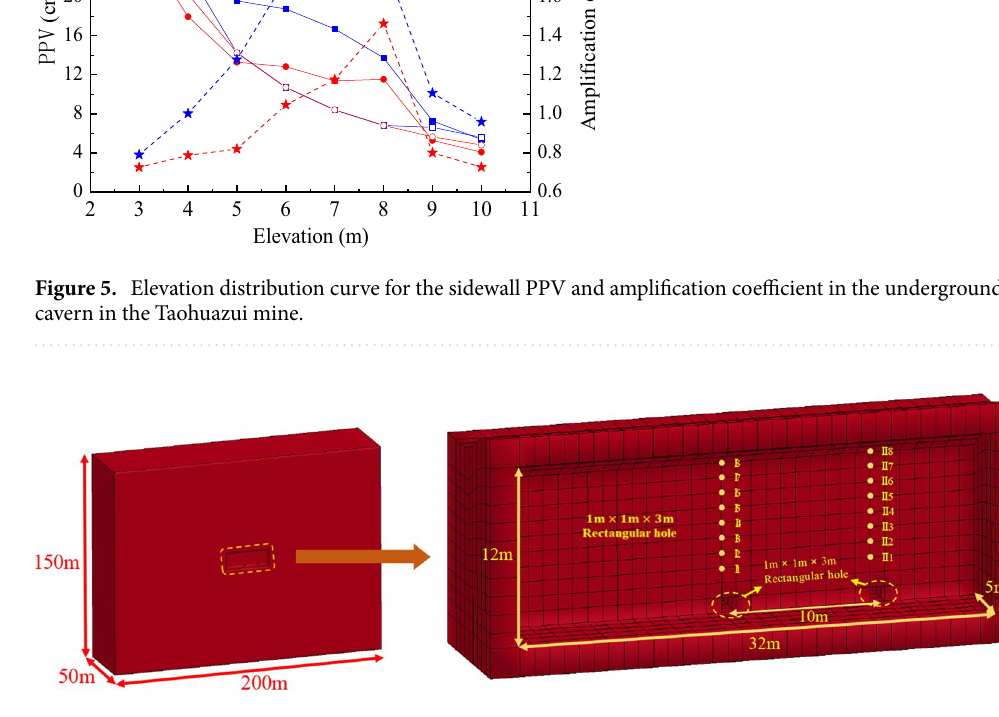
Figure 6. Diagram of the numerical model